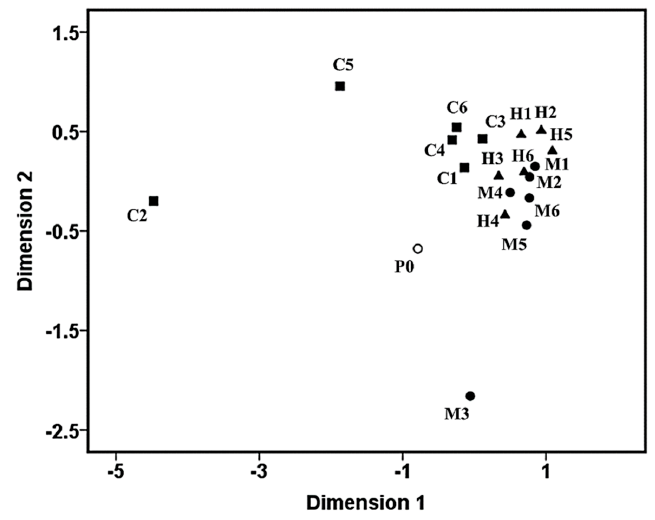
Figure 3. Clustering patterns of the antifouling (AF) capacity of the PDMS-based nanocomposites based on the MDS analysis.